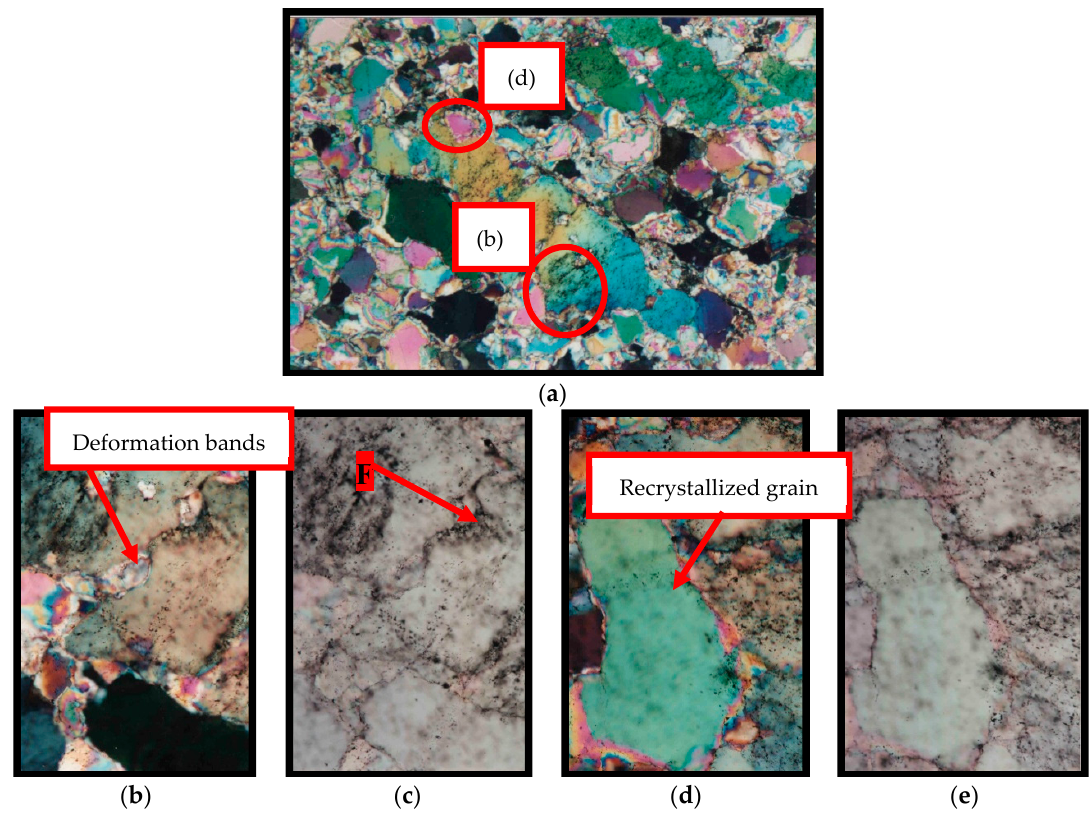
Figure 17. Micrographs obtained by optical microscopy evidencing the presence of fluid inclusions in the deformed quartz, where F = fluid. ( a ) Micrograph of the region containing deformed and recrystallized quartz, crossed-polarized; ( b , c ) deformed quartz with inclusions in deformation bands, crossed-polarized and natural light; ( d , e ) recrystallized quartz without fluid inclusions, crossed-polarized and natural light [18].